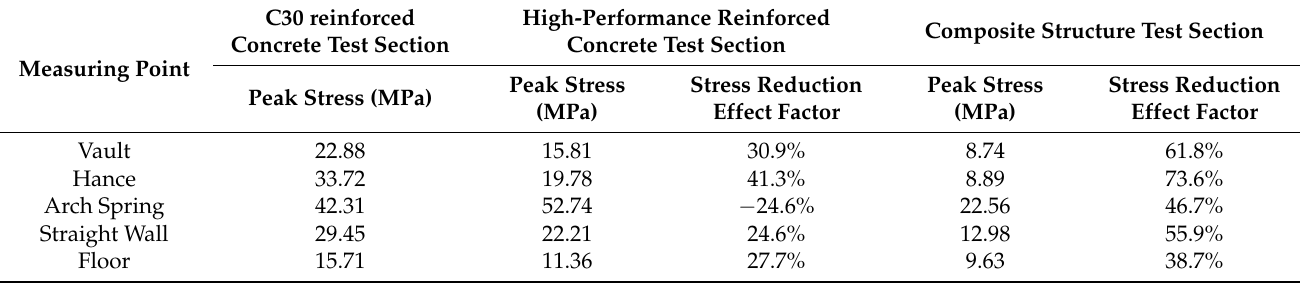
Table 7. The peak stress of each measured point in the structural inner